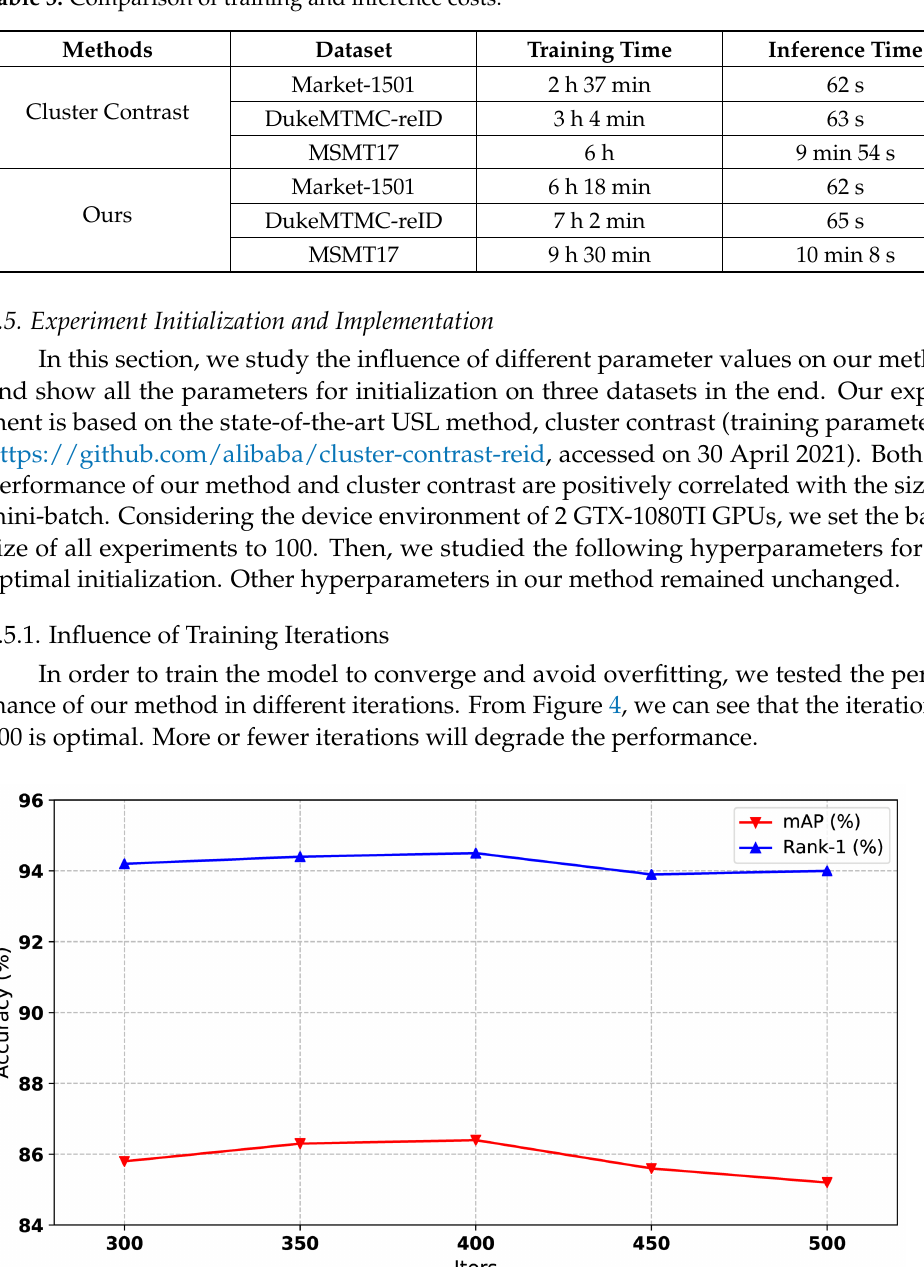
Table 3. Comparison of training and inference costs.